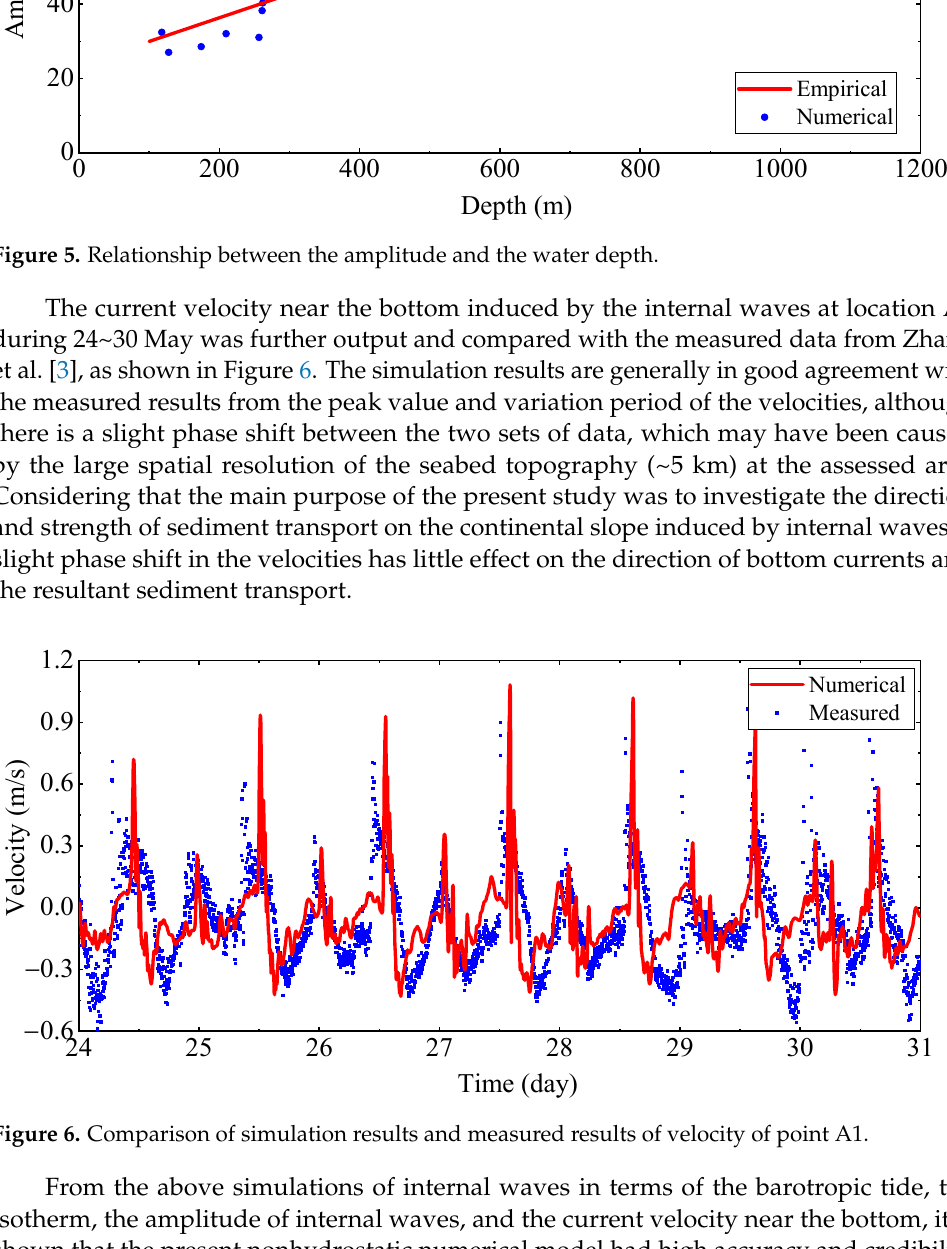
Figure 4. Isotherm and its filtering results for the simulation of point S7.